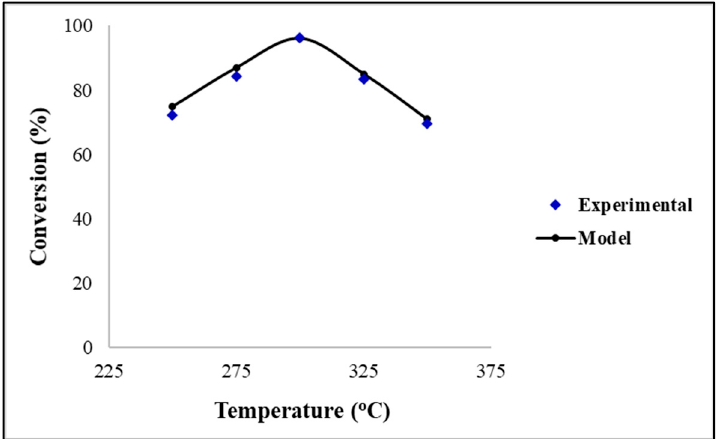
Figure 1. Conversion of TG against reaction temperature with Ni/ZrO 2 . Reaction conditions: pressure = 30 bar, H 2 /oil ratio = 1000 and inlet liquid flow = 0.1 mL/min.